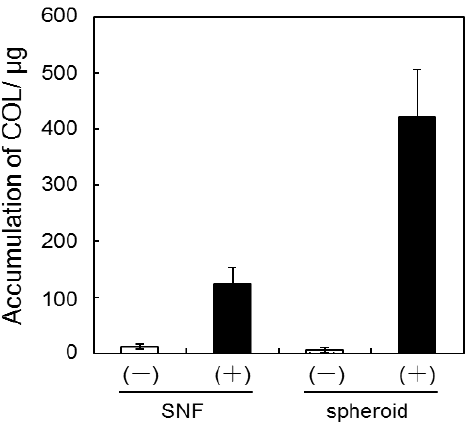
Figure 4. Accumulation of collagen (COL) in MSCs on 3D silica fibers and spheroids cultured in normal medium (Diff (−)) and chondrogenic differentiation medium (Diff (+)) for 4 weeks.